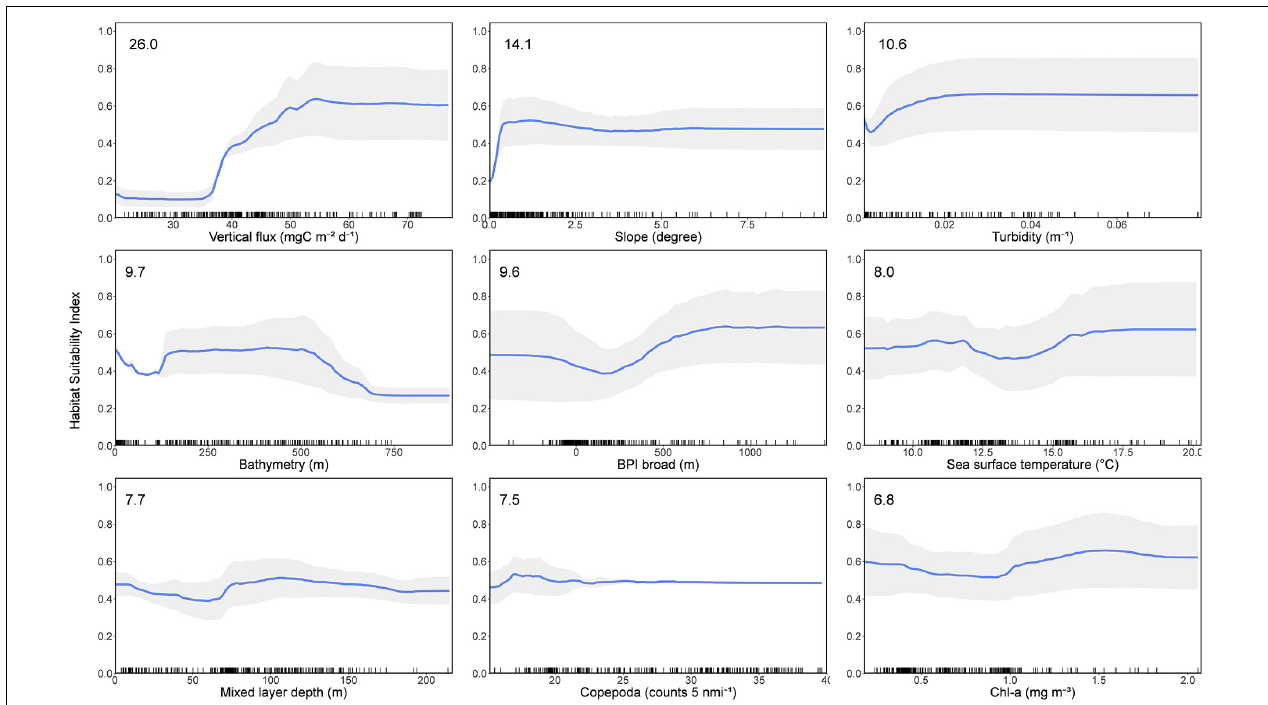
FIGURE 2 | Partial dependence plots of the mean boosted regression tree (BRT) and random forest (RF) models for the nine variables (time series 1889–2020), showing the influence of each predictor variable on the response. Variables are ordered by influence as indicated in top left hand of plots. Shaded area represents standard